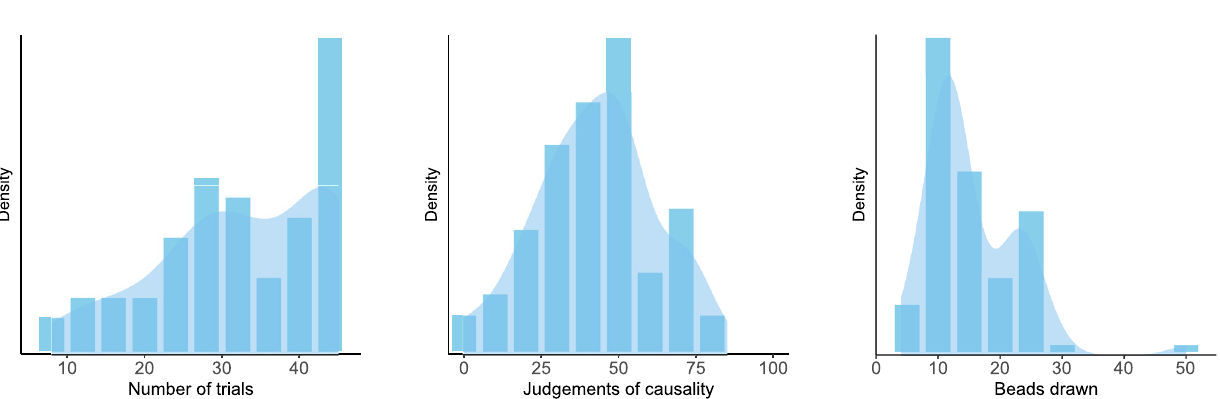
Figure 8. Histograms and density plots for the contingency learning task (left and central panels) and Beads task (right panel) in Study